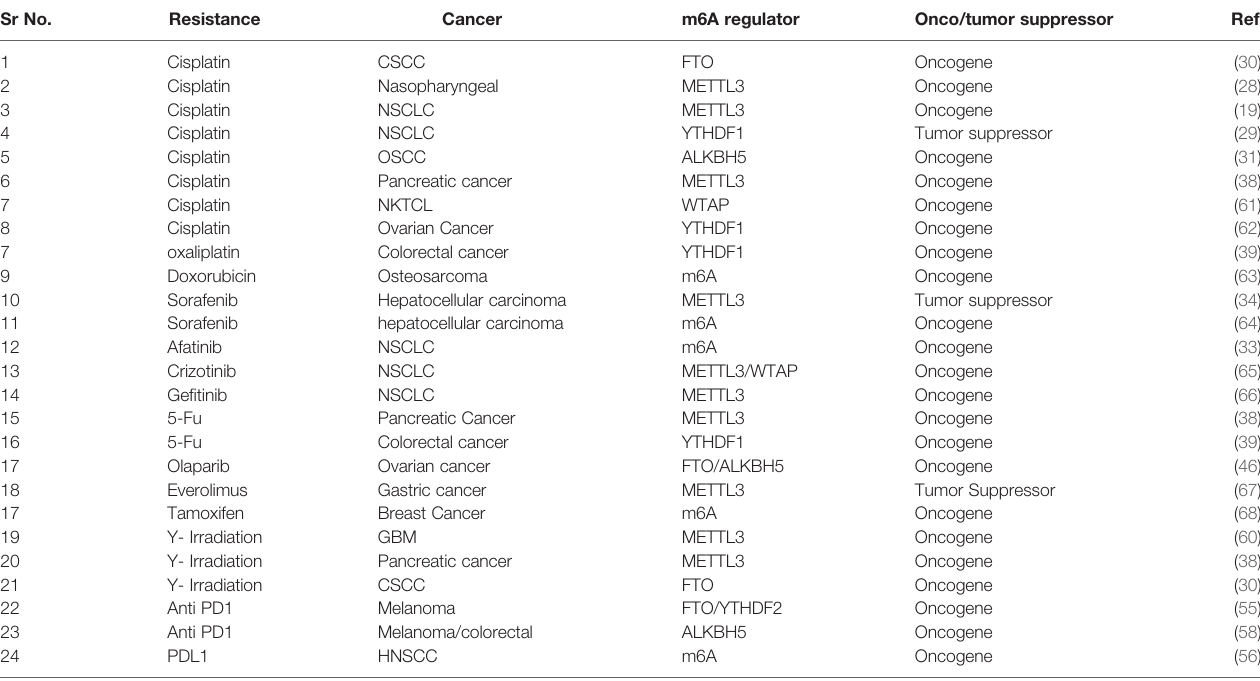
TABLE 1 | Summary of m6A RNA modi fi cation in therapy resistant cancer cells. Sr